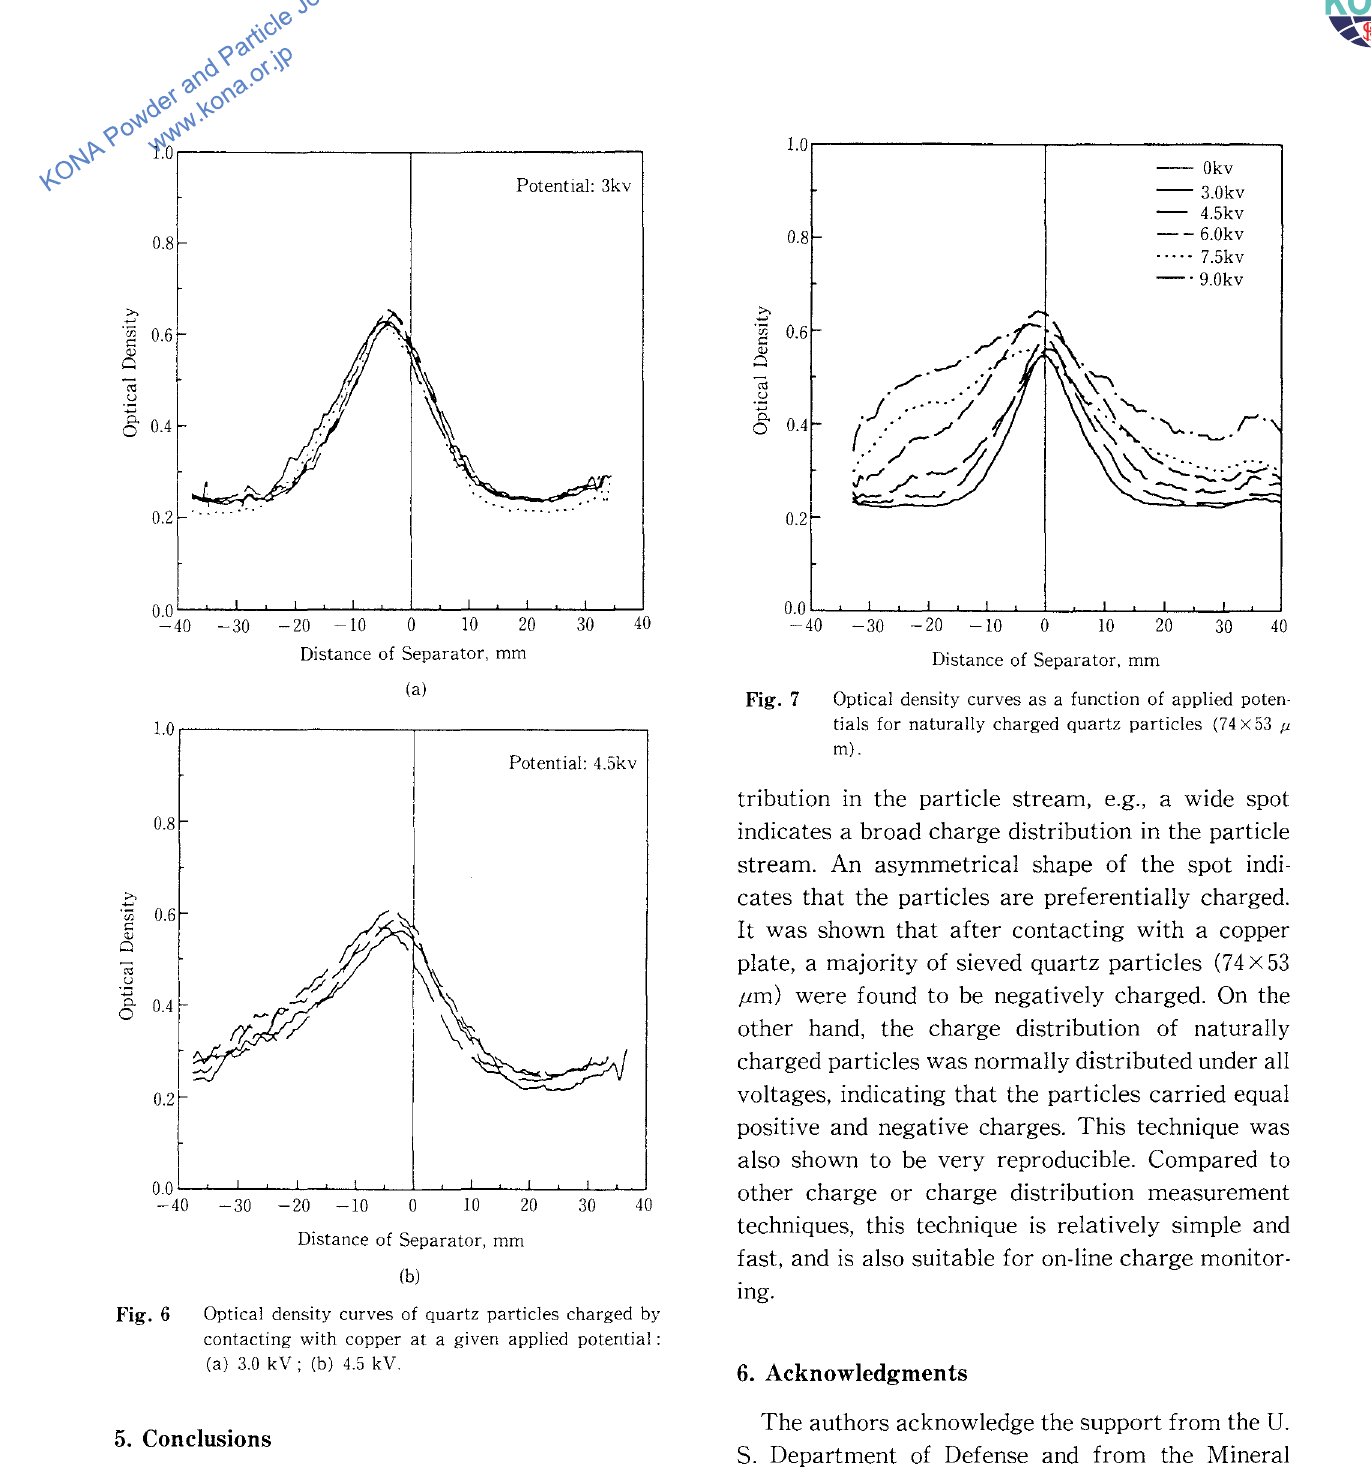
Fig. 6 Optical density curves of quartz particles charged by contacting with copper at a given applied potential : (a) 3.0 kV; (b) 4.5 kV.